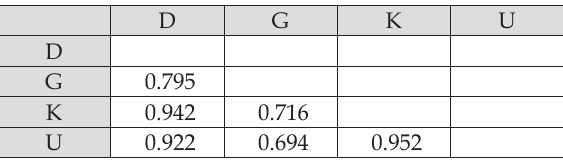
Table 7. Correlation matrix of socio-economic